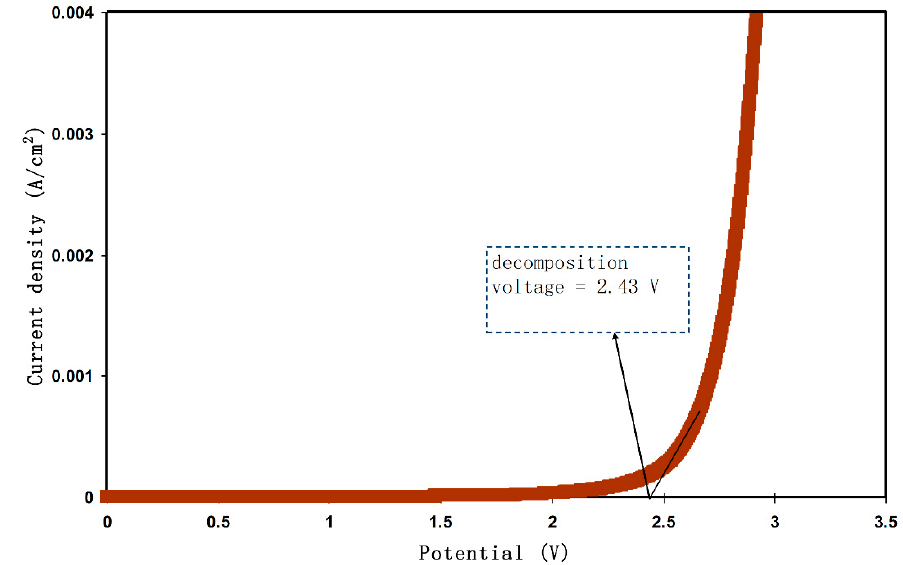
Figure 5. LSV curve for the CSPX4 sample with highest conductivity.